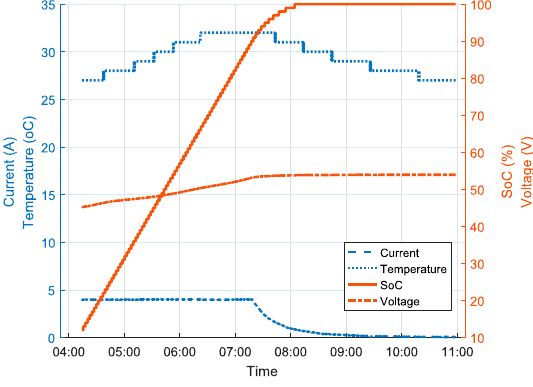
Figure 16. Battery charging process.